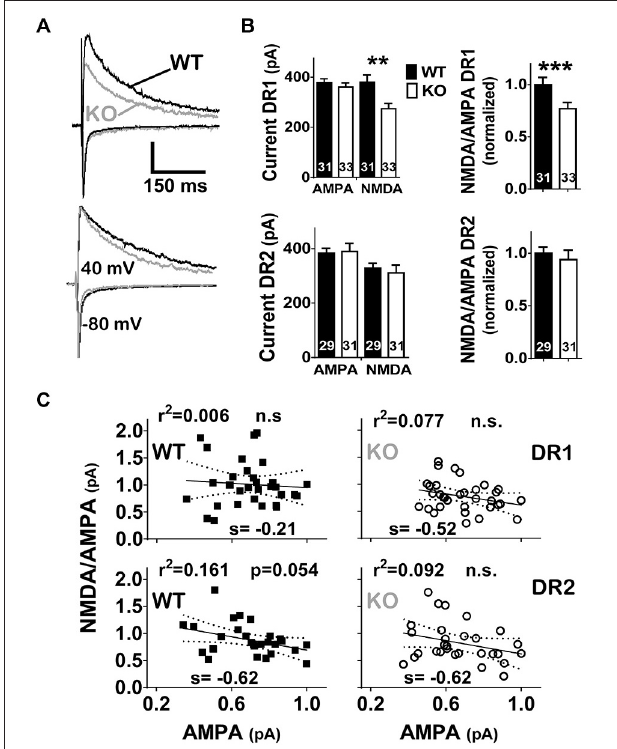
FIGURE 2 | NL1 KO mice show a DR1 specific reduction in NMDAR neurotransmission. (A) eEPSCs were elicited as in Figure 1 but AMPAR current peak was required to be in the range of 200–600 pA. Traces of WT (black) or KO (gray) mice were superimposed. The amplitude of AMPAR current for the trace corresponding to the DR1-WT cell was 522 pA. The amplitude of the AMPAR current for all other cells in this figure were scaled to that of DR1-WT and all NMDAR currents were proportionally scaled. Actual amplitudes for scaled-AMPAR currents in this figure were: 437 pA, 378 pA and 404 pA, for DR1-NL1 KO, DR2-NL1 WT and DR2-NL1 KO cells, respectively. Vertical bar = 250 pA. (B) Bar graphs of current amplitudes (left) for AMPARs and NMDARs or for the NMDA/AMPA ratio (right). NL1 KO mice showed a deficit in NMDAR currents, as well as a reduction in the NMDA/AMPA ratio, but only in the direct pathway. ** p < 0.01, *** p < 0.001. (C) Regression analysis of normalized AMPAR currents vs. the NMDA/AMPA ratio. AMPAR currents of NL1 KO mice were normalized to the maximal peak current for their WT control group within the direct or indirect pathway. The NMDA/AMPA ratio showed no significant correlation to the normalized amplitude of the AMPAR current.